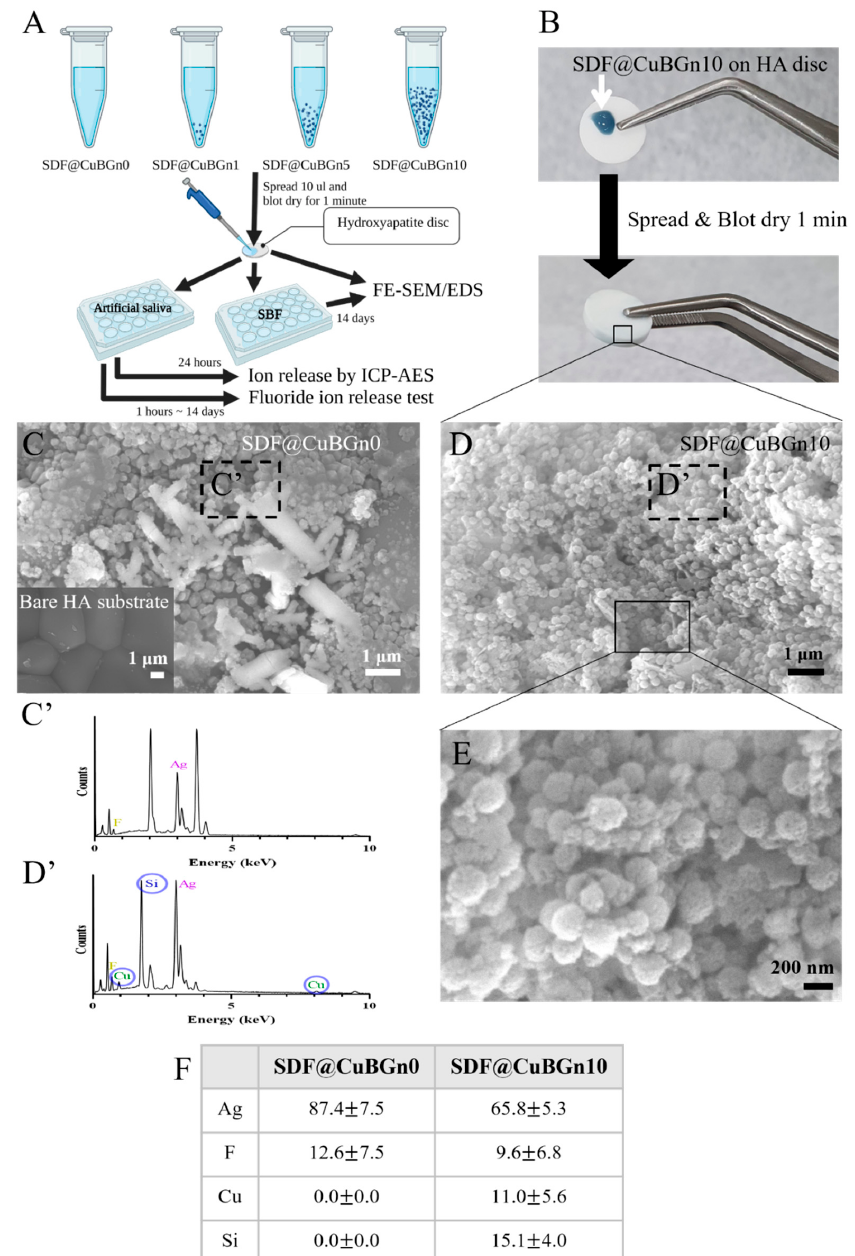
Figure 2. Physicochemical analysis (morphology and surface elemental analysis) of hydroxyapatite (HA) discs with SDF@CuBGn. ( A ) Schematic illustration of the physicochemical analysis of HA discs with SDF@CuBGn. Ten microliters of SDF@CuBGn were spread on HA discs (diameter 9.5 mm, thickness 1.8 mm) and blotted for 1 min. Discs were prepared and examined by FE-SEM and EDS after SDF@CuBGn was applied, immersed in simulated body fluid (SBF, at pH 7.4 and 37 ◦ C) for 14 days, and ion release tests were performed after soaking in artificial saliva (37 ◦ C, being agitated). ( B ) Actual picture of spreading SDF@CuBGn10 on HA discs. ( C ) HA disc with no treatment (bottom left) and SDF@CuBGn0, ( D ) SDF@CuBGn10 on HA disc analyzed with FE-SEM (10,000 × , 20 kV) and ( C’ ), ( D’ ) EDS analysis of parts of ( C ) and ( D ). Ag and F were found in both samples, and Cu and Si were detected only in SDF@CuBGn10. ( E ) Magnified FE-SEM of SDF@CuBGn10 (40,000 × , 20 kV). The spherical morphology of CuBGn, which was not seen in ( C ) SDF@CuBGn0, was found. ( F ) EDS analysis of components of SDF@CuBGn-applied HA discs